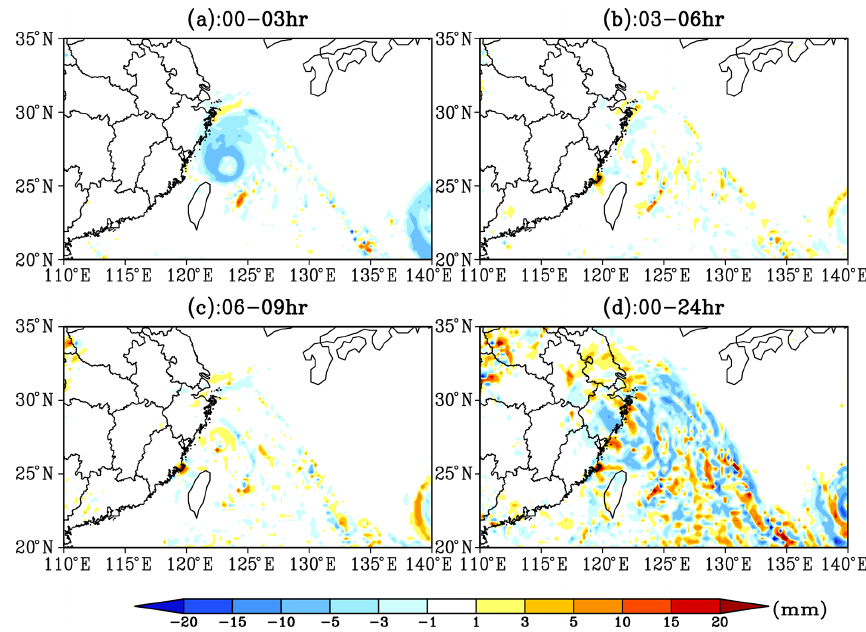
Figure 10. Distribution of the differences (G00 minus G21) of 3-hourly and 24h accumulated precipitation (since 00:00UTC 8 August 2019) of the typhoon Lekima simulated by G00 and G21 experiments (values are given in mm).